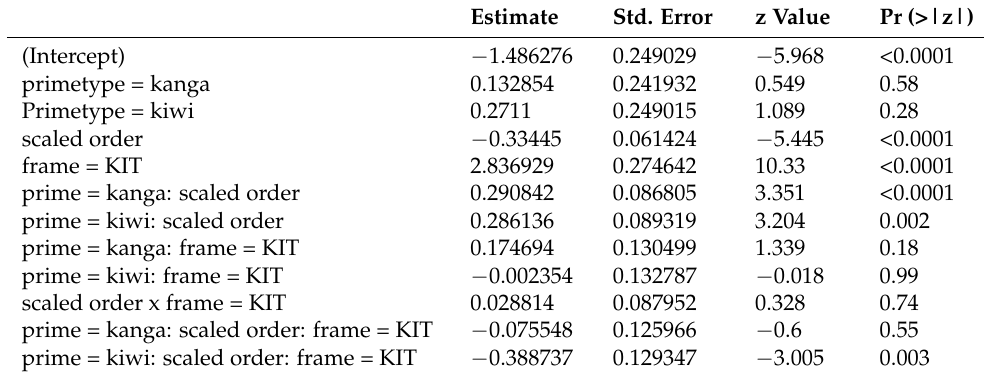
Table 7. Selected model for experiment two (dependent variable is KIT-consistent response. Intercepts are participant and